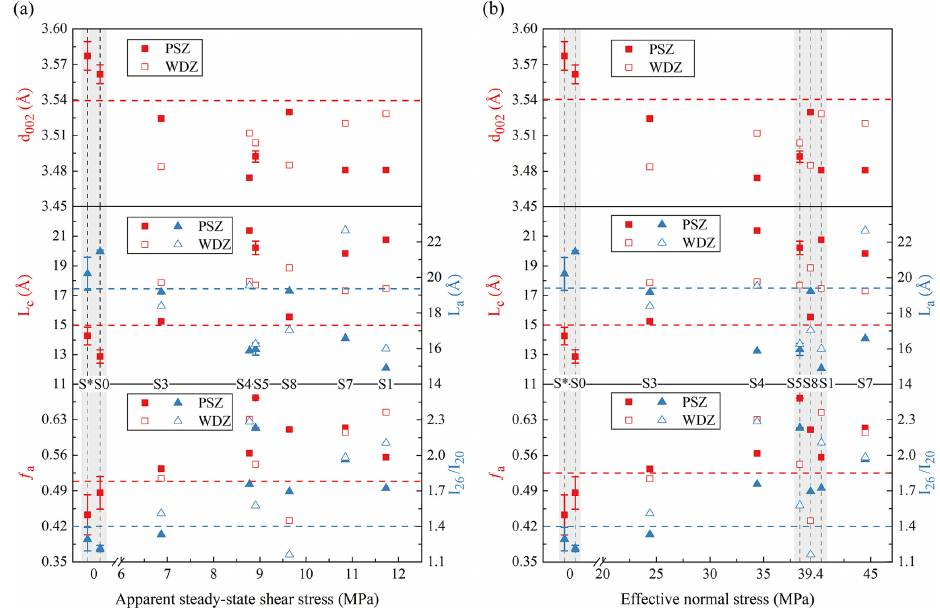
Figure 9. Representative crystal structure parameters obtained from samples S ∗ –S8 versus apparent steady-state shear stress measured at a shear displacement of ∼ 5 . 7mm and effective normal stress with the corresponding sample number in (a) and (b) , respectively. The data offset is given in the grey area; i.e., the data plotted on the vertical dashed lines were obtained at 0MPa (non-sheared samples) or ∼ 40MPa effective normal stress but are horizontally offset here for readability. Solid and hollow squares or triangles represent the values for the PSZ and WDZ retrieved from the sheared samples, respectively. The error bars for samples S ∗ , S0 and S5 are the standard deviations.